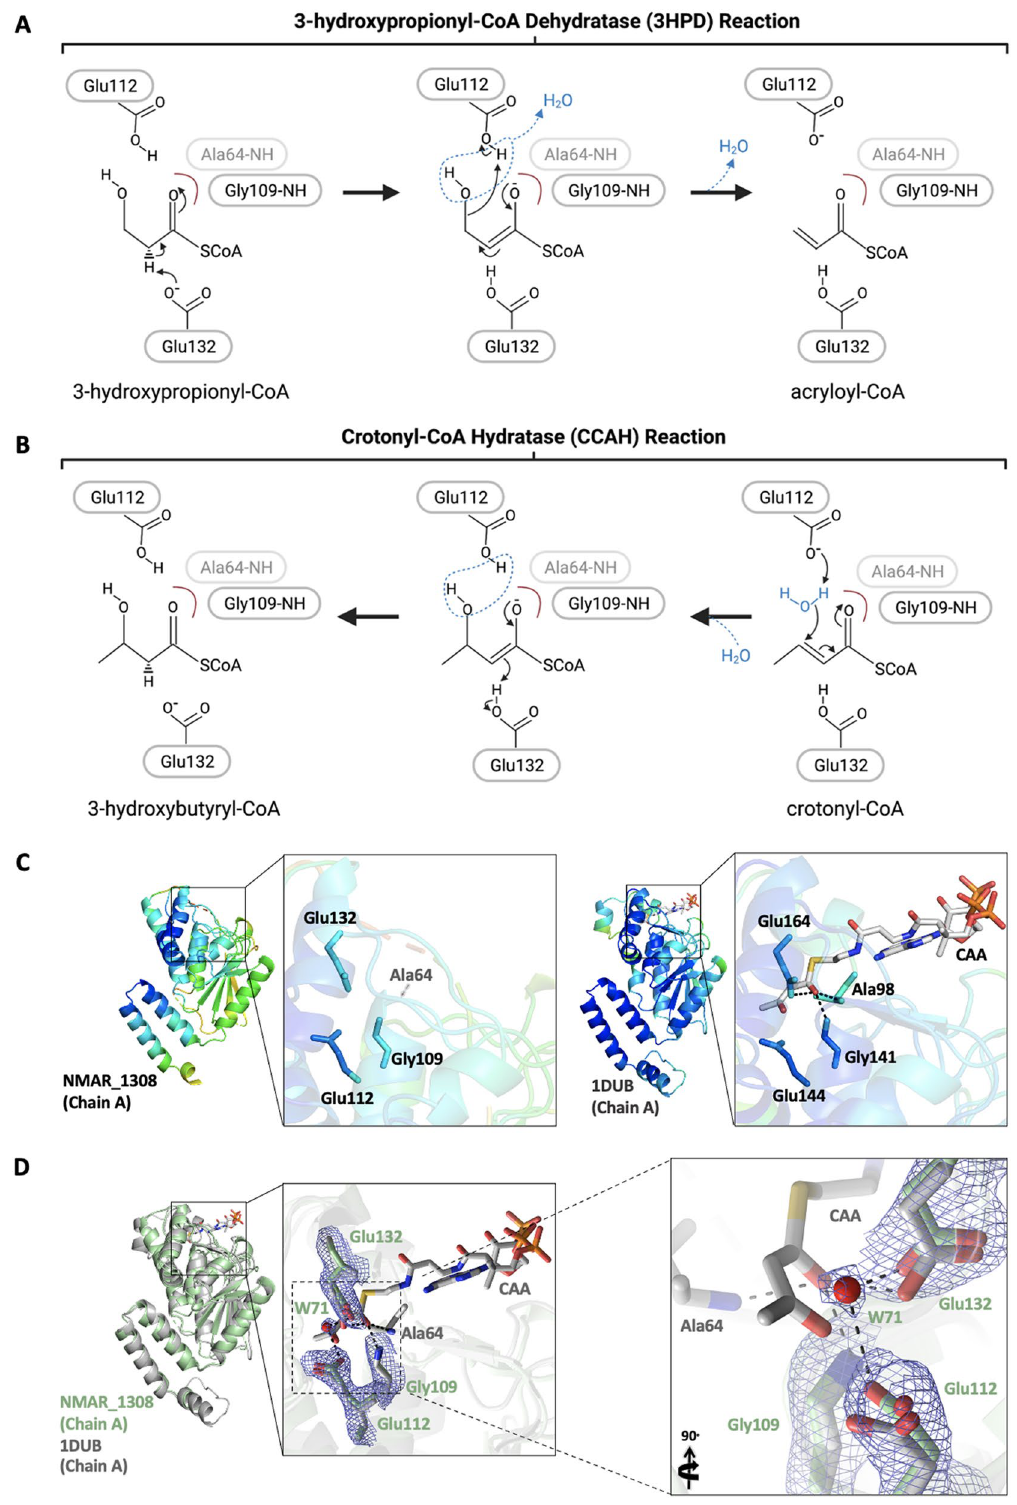
Figure 3. Representation of hydratase/dehydratase active sites. The proposed mechanism of hydratase ( A ) and dehydratase ( B ) reactions by Nmar_1308. One of the two residues forming the oxyanion hole for the catalyst, Ala64 is missing in our structure, but is indicated in faint gray at the putative position. ( C ) The ligand binding pocket is shown for Nmar_1308 structure and the 2-enoyl-CoA hydratase structure (PDB ID: 1DUB) to compare the stability around the binding pocket. The ligand of 1DUB structure, acetoacetyl- CoA (CAA) is colored in gray. (D) Superposition of the apo-form Nmar_1308 protein and the structure of rat liver mitochondrial enoyl-CoA hydratase complexed with acetoacetyl-CoA. The Nmar_1308 structure is colored in pale green while the superposed enoyl-CoA hydratase structure (PDB ID: 1DUB) is colored in gray. Hydrogen bond interactions are shown with dashed lines in black. The 2Fo-Fc electron density of the Nmar_1308 is contoured at 1 σ level and colored in slate. Panel A and B are created with BioRender. com. Panel C and D are generated by PyMOL (www. schro dinger. com/